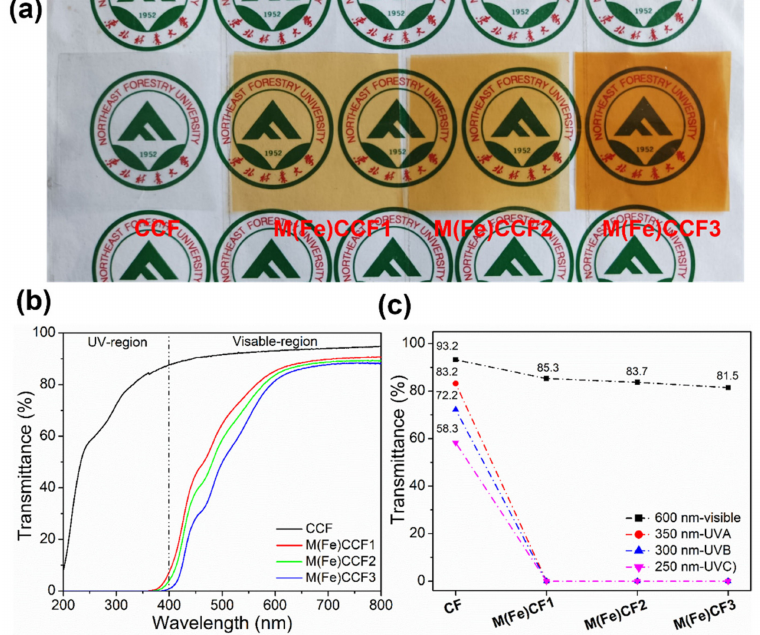
Figure 5. ( a ) Photographs of CCF and M(Fe)CCFs; ( b ) UV-vis light transmittance curves of CCF and M(Fe)CCFs from 200 to 800 nm; ( c ) Transmittance at specific UV light